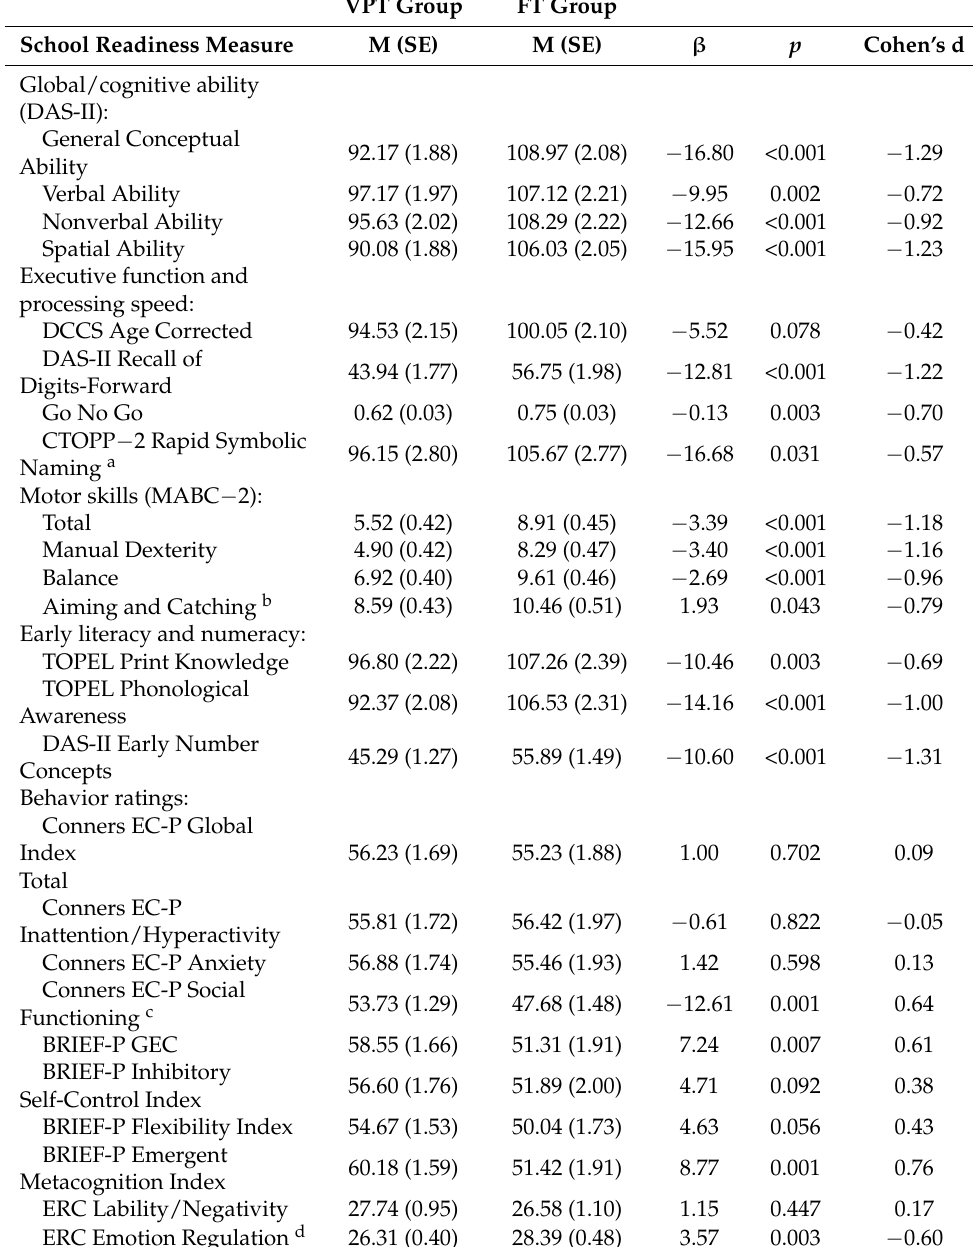
Table 3. Group differences in readiness